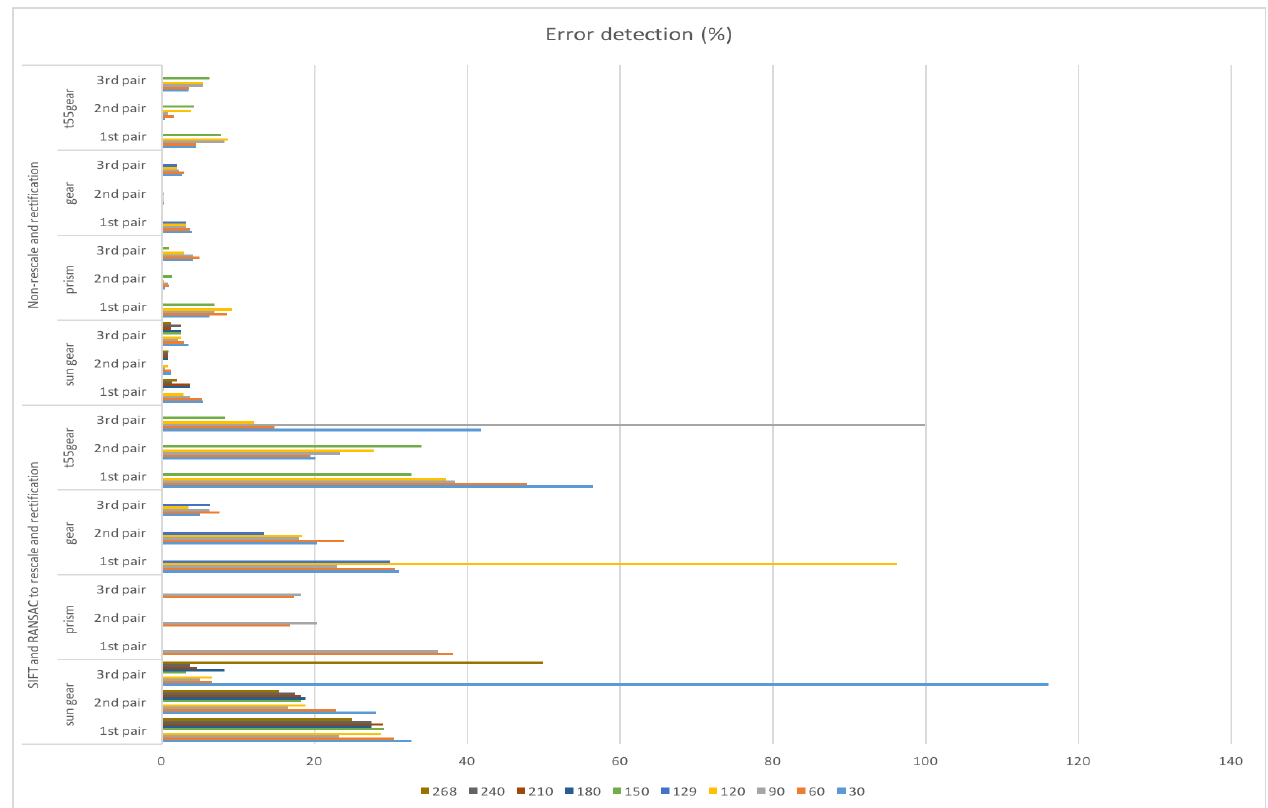
Figure A1. Summary of image pre-processing: the error detection of normal printing state for ( a ) sun gear; ( b ) prism; ( c ) gear; and ( d ) t55gear.